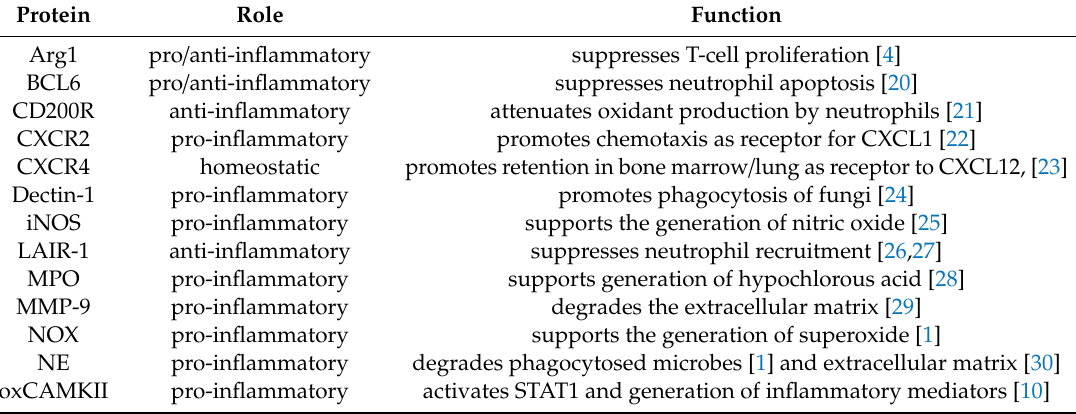
Table 1. Diverse roles of neutrophil signaling and e ff ector proteins. Neutrophil e ff ector proteins, such as proteases and phagocytic receptors, and receptors involved in chemotaxis, contribute to the plasticity of neutrophils in driving inflammation, promoting resolution, or maintaining homeostasis. Abbreviations: Arg1, arginase-1; iNOS, inducible nitric oxide synthase; LAIR-1, leukocyte-associated Ig-like receptor